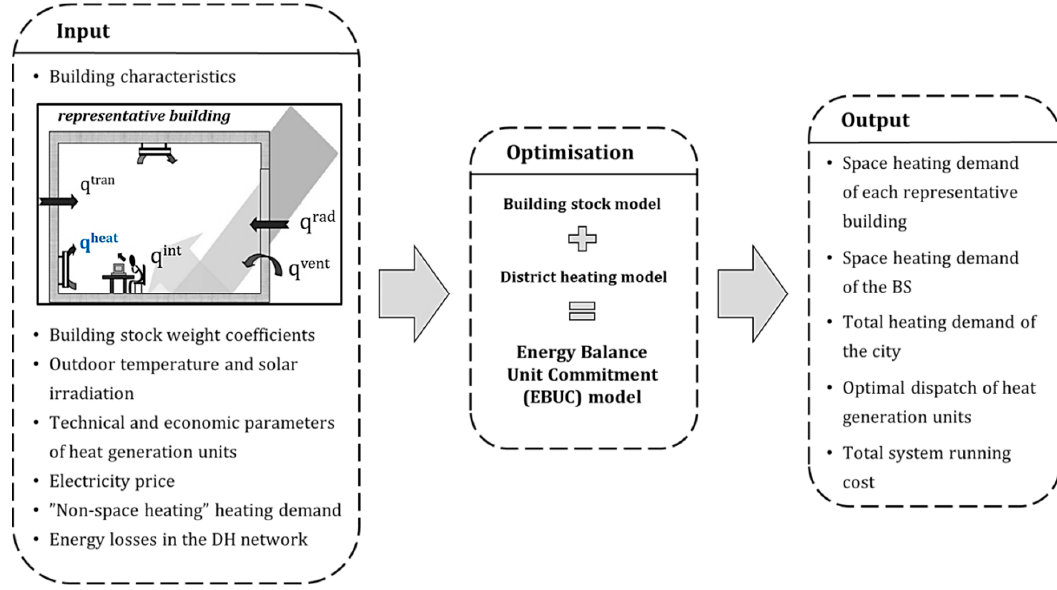
Figure 1. Overview of the modeling approach used in this work.